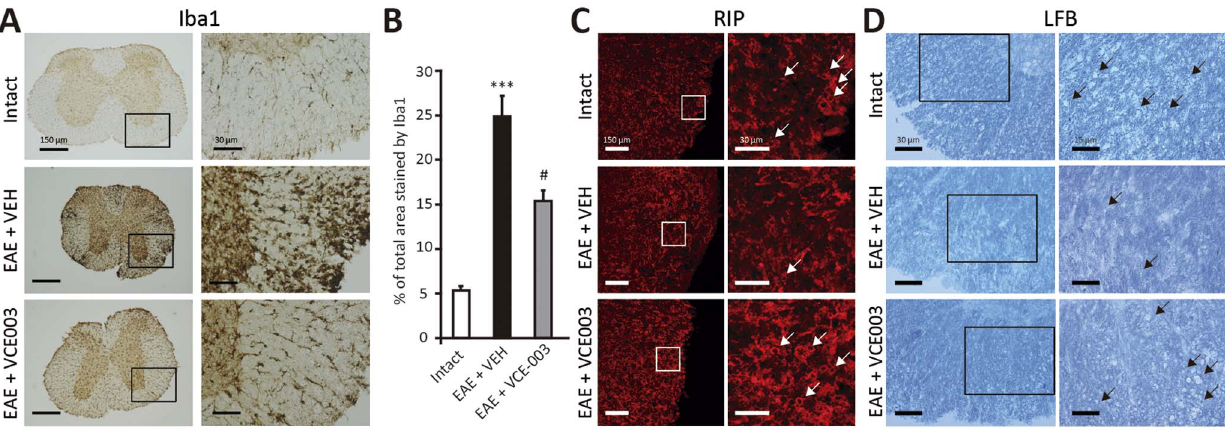
Figure 5. VCE-003 significantly reduces microglial activation and preserves myelin structure. (A) VCE-003 notably reduces microglial activation (Iba1 + cells). (B) Quantification of Iba1 + cells are shown as means 6 SEM (***p , 0.001 vs Intact; # p=0.021 vs EAE + VEH). Thoracic spinal cord sections from symptomatic animals show a clear disruption of myelin, whereas exposure to VCE-003 contributes to maintain the myelin structure (C, RIP immunofluorescence staining; D, LFB